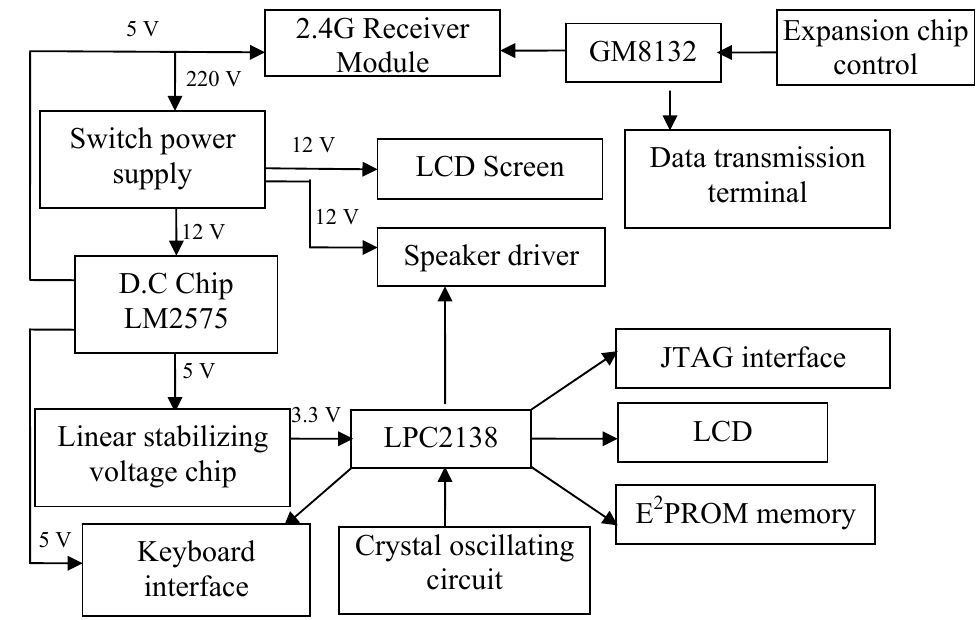
Figure 8. The architecture of base station